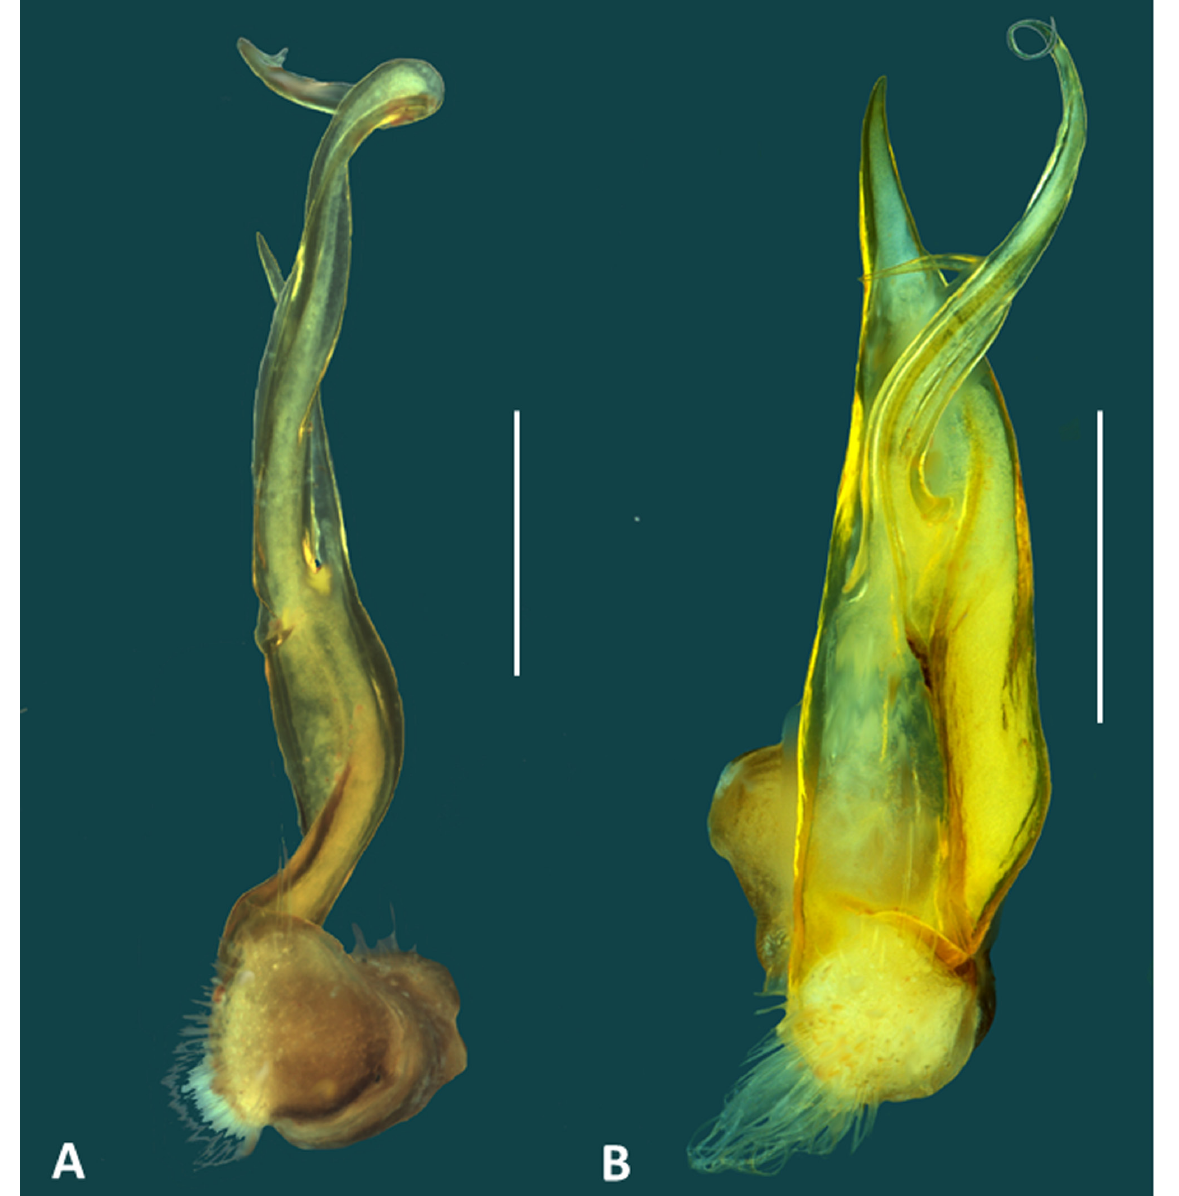
Fig. 1. Posterior view of left gonopod of Boreohesperus spp. A . Boreohesperus capensis Shear, 1992. B . B. vascellus sp. nov. Scale bars: